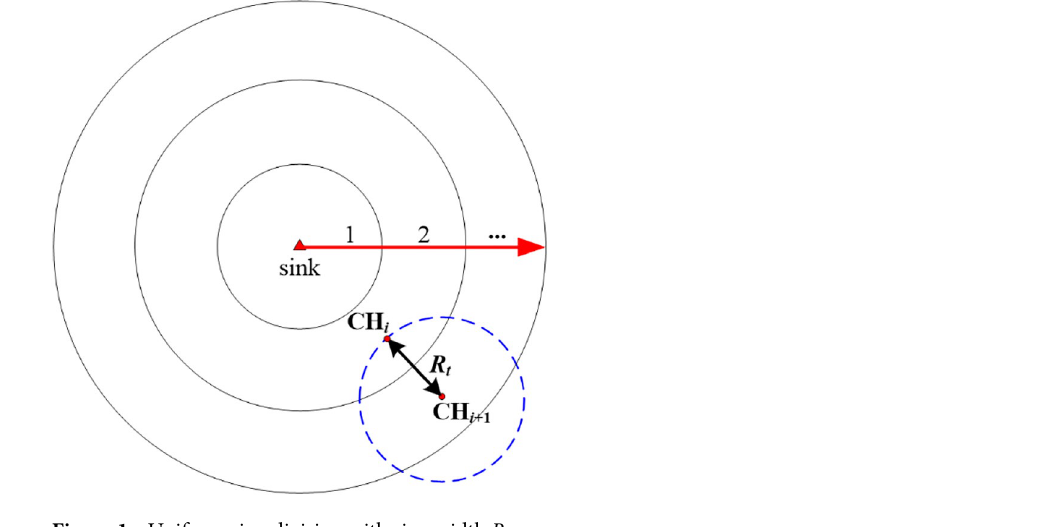
Figure 1. Uniform ring division with ring width R t